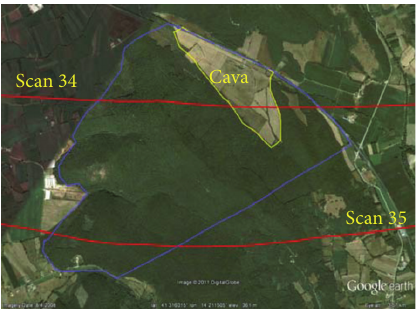
Figure 14: Performed tracks over an ancient volcanic hill located in the Roccamonfina site (South Italy).